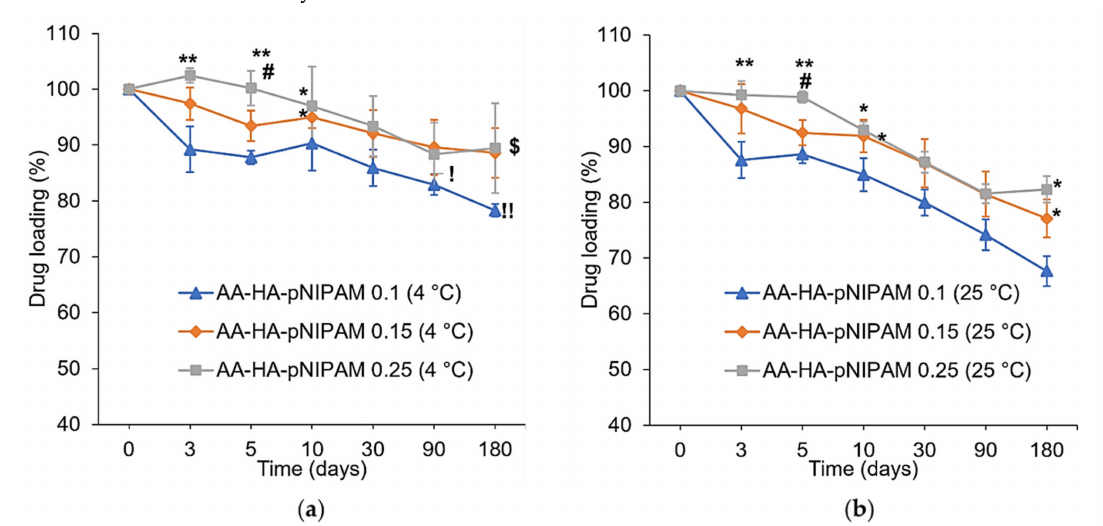
Figure 4. Analysis of % drug loading at ( a ) 4 ◦ C and ( b ) 25 ◦ C/60% RH, over six months (mean ± SD, n = 3). * p < 0.05, ** p < 0.01 vs. AA-HA-pNIPAM 0.1 (4 ◦ C) in ( a ) and AA-HA-pNIPAM 0.1 (25 ◦ C) in ( b ). # p < 0.01 vs. AA-HA-pNIPAM 0.15 (4 ◦ C) in ( a ) and AA-HA-pNIPAM 0.15 (25 ◦ C) in ( b ). ! p < 0.05, !! p < 0.01 vs. AA-HA-pNIPAM 0.1 (25 ◦ C). $ p < 0.05 vs. AA-HA-pNIPAM 0.15 (25 ◦ C).